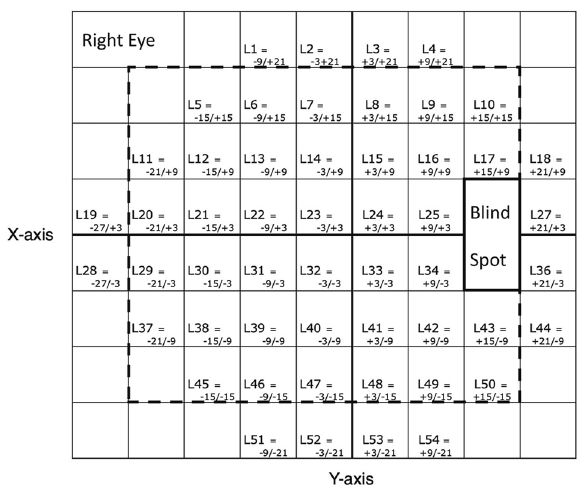
Figure 1. The 54 perimetric locations of the 24-2 grid (after excluding the blind spot) as they are plotted based on x and y axes. Dotted rectangle indicate 38 perimetric locations of the 24-2 grid that were included in the analysis of the current study. This format is for the right eye.